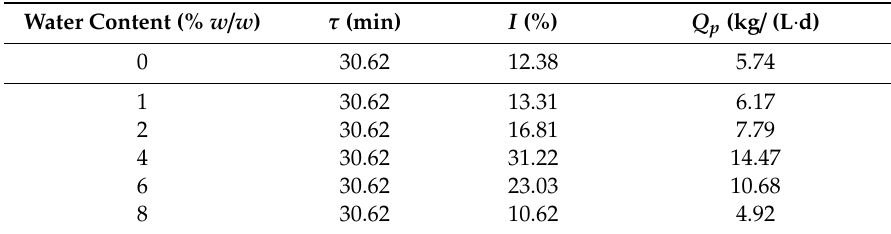
Table 3. Comparison of biodiesel yield and volumetric productivity for di ff erent DES water content in the transesterification reaction catalyzed by